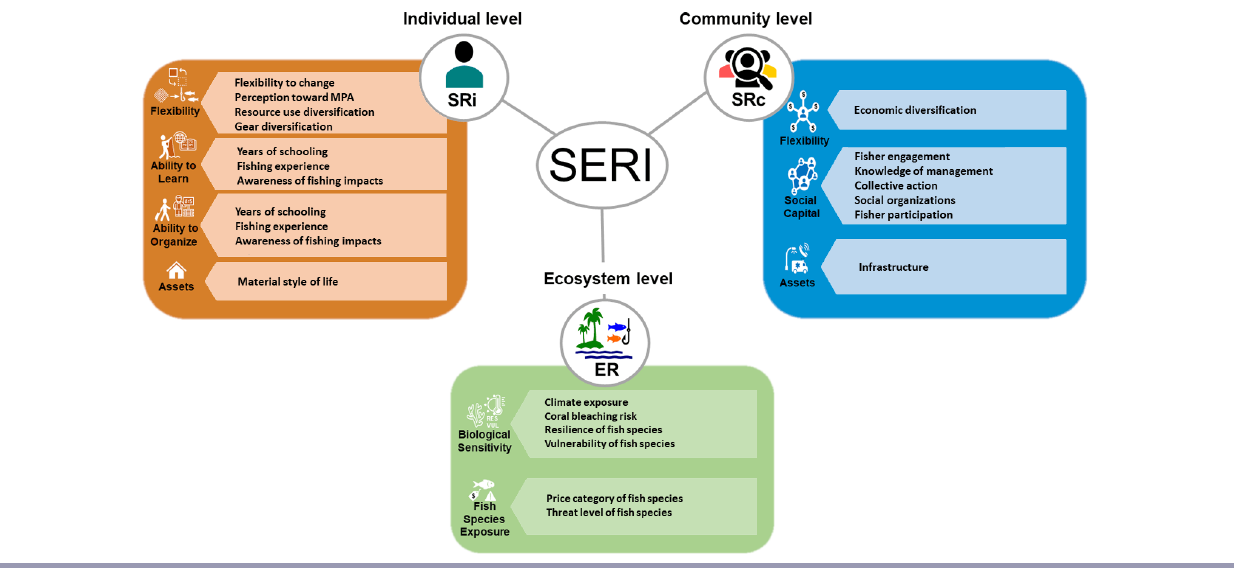
Fig. 2 . Proposed components (three circles forming SERI), indicators (represented by icons), and subindicators (variables described in each of the three rectangles) to measure the social-ecological resilience index (SERI) of small-scale fishers, where SERI = (SRi + SRc + ER)/3. SRi = Social Resilience at the individual level; SRc = Social Resilience at the community level; ER = Ecological Resilience.